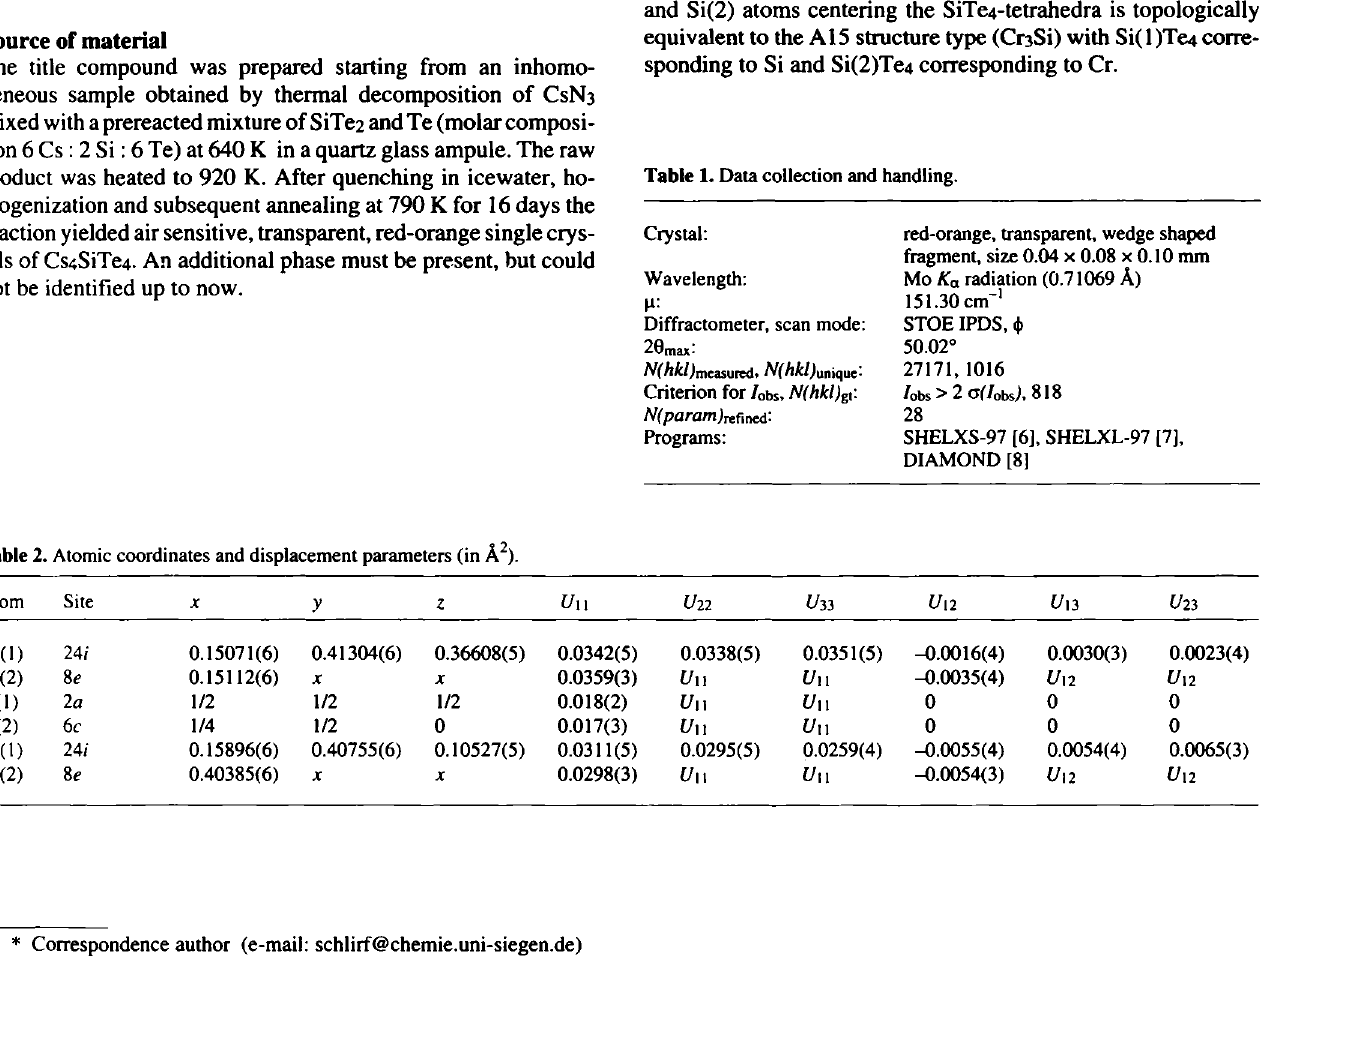
Table 2. Atomic coordinates and displacement parameters (in A 2